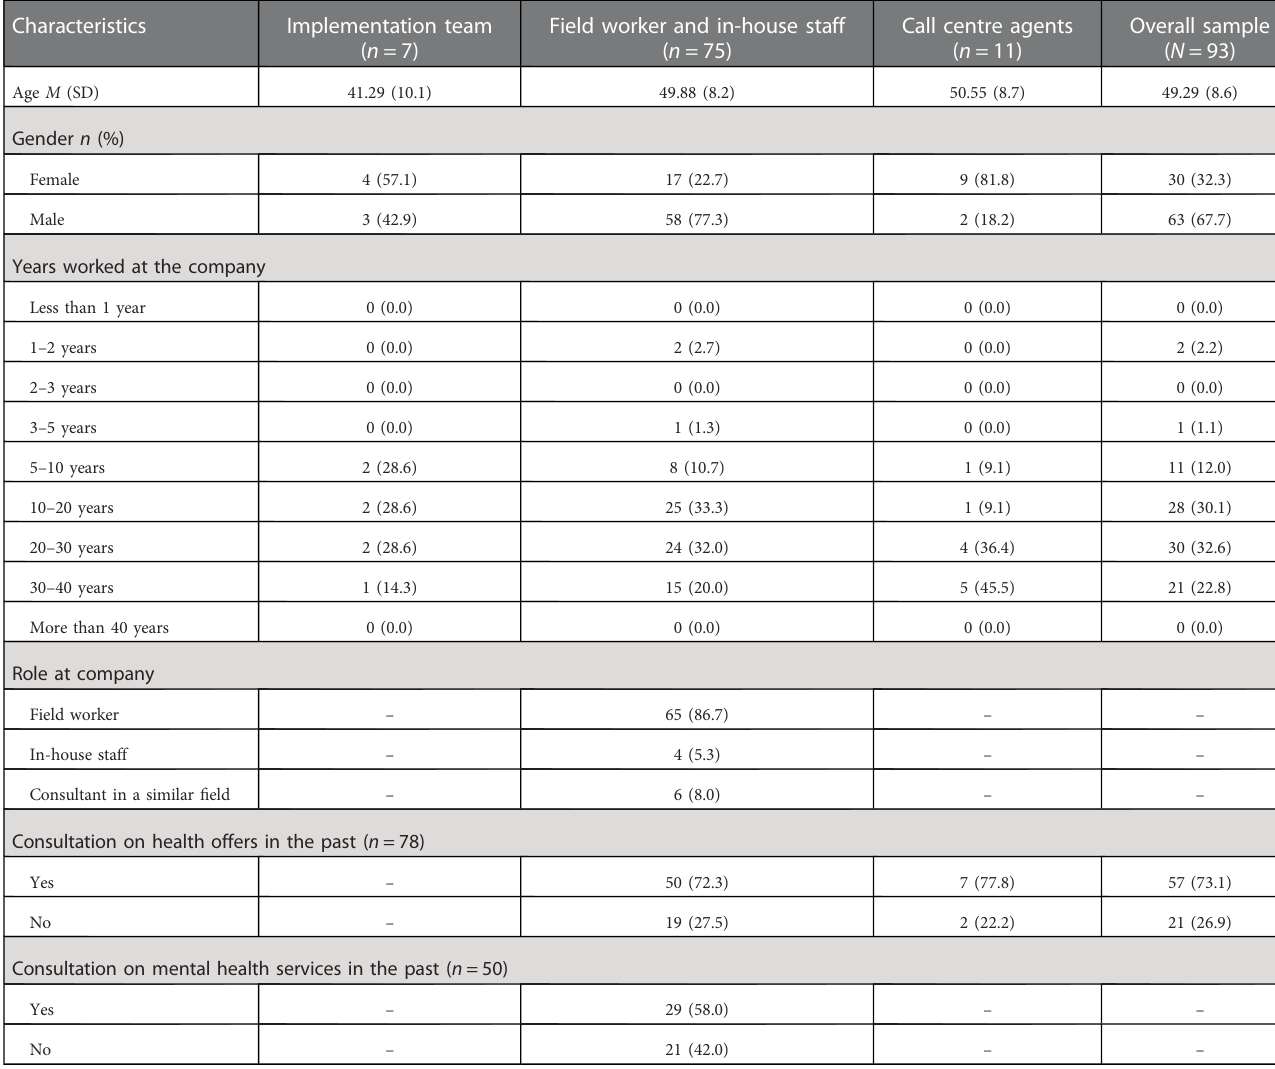
TABLE 3 Sociodemographic data of the employees participating in the implementation study, presented by occupational group and the overall sample ( N = 93).